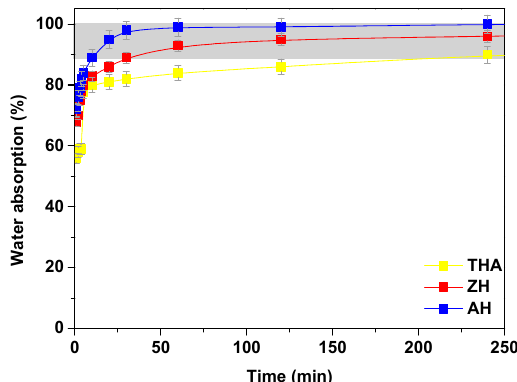
Figure 8. Moisture retention capacity in distilled water for THA, ZH and AH.